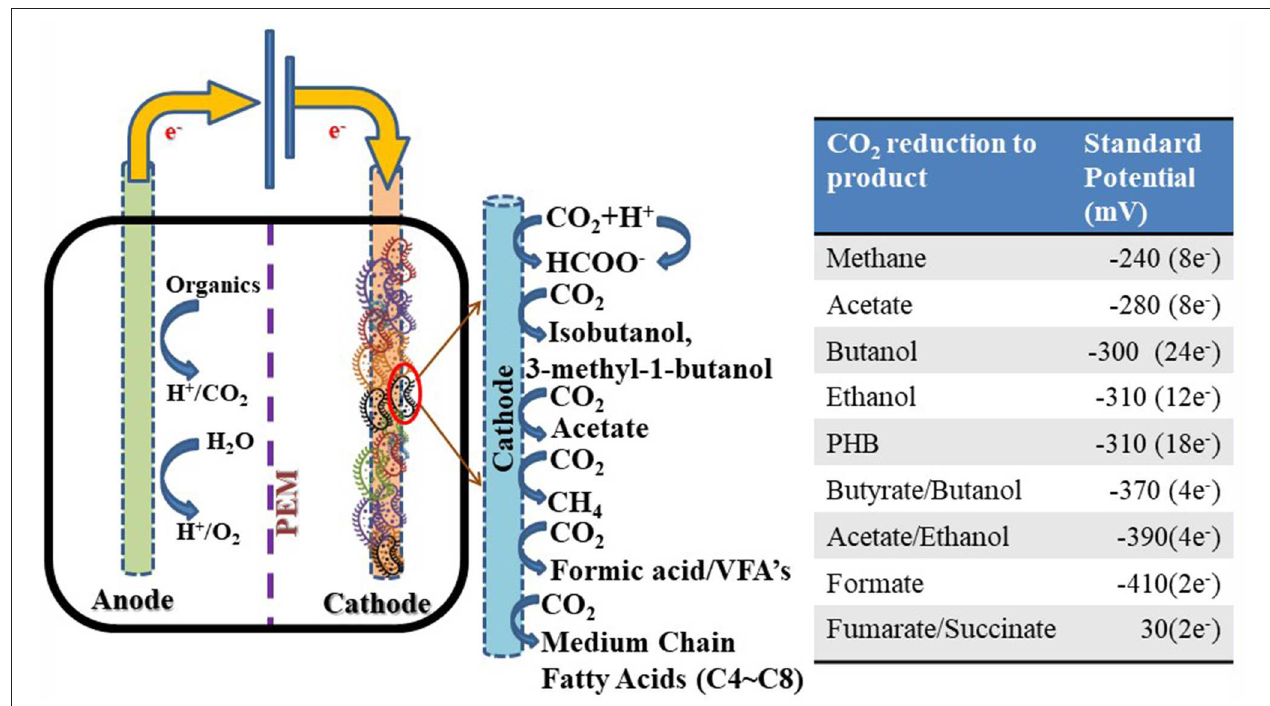
FIGURE 4 | Schematic representation of microbial electrosynthesis system toward CO 2 reduction for value-added product formation and their corresponding standard potentials.